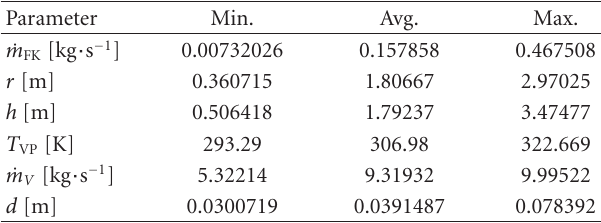
Table 4: SA parameter setting.